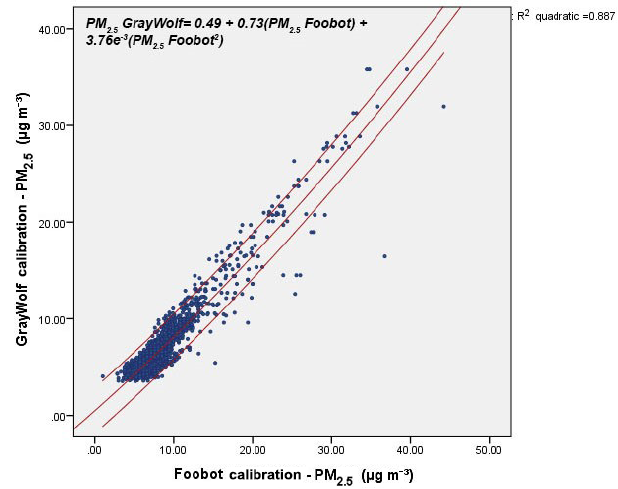
Figure 10. Scatter plot of the 5min CO 2 concentration measured using the Foobot FBT0002100 and the GrayWolf IQ-410 from the calibration dataset.